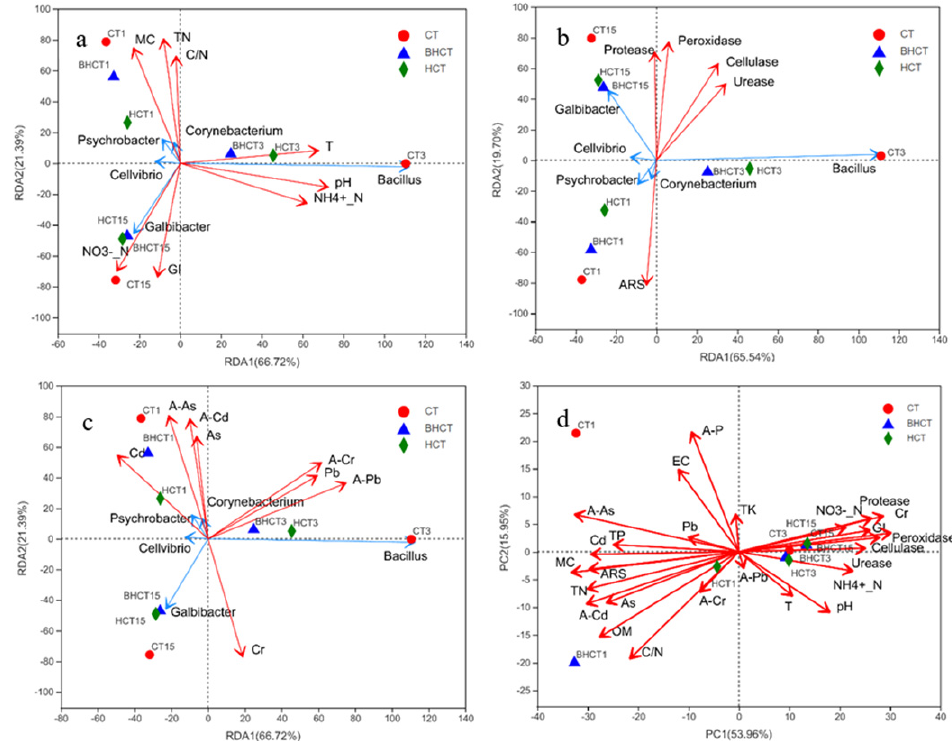
Figure 6. Redundancy analysis of HMRB bacterial community in relation to ( a ) environmental factors, ( b ) enzyme activity, and ( c ) heavy metals. ( d ) Principal coordinates analysis.